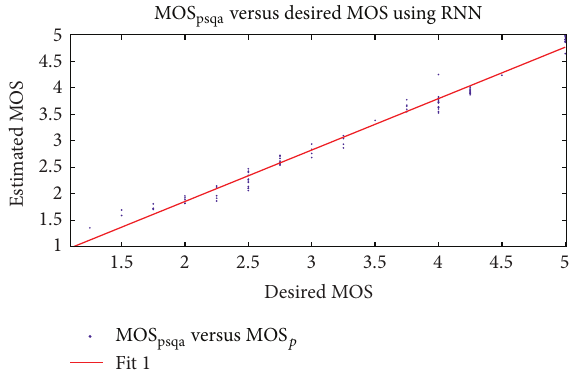
Figure 11: Correlation between MOS psqa and MOS expected through the